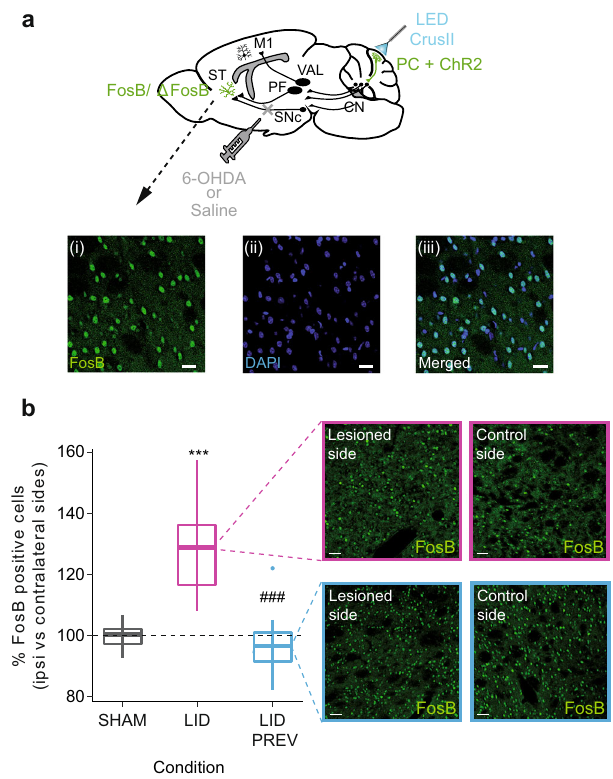
Fig. 7 Striatal overexpression of the dyskinetic marker FosB/ Δ FosB is restored by Purkinje cell stimulation. a Sagittal schematic showing neurons in the striatum expressing the dyskinetic marker FosB/ Δ FosB (green). The cerebello-thalamo-cortical and cerebello-thalamo-striatal pathways are represented in mice expressing ChR2-YFP in Purkinje cells (PC + ChR2, green) as well as the injection site 6-OHDA or saline (gray). ST: Striatum; SNc: substantia nigra pars compacta ; M1: Primary motor cortex, VAL: Ventroanterior-ventrolateral complex of the thalamus, PF: Parafascicular nucleus of the thalamus, CN: cerebellar nuclei, CrusII: Crus2 of the ansiform lobule. Insets: Postmortem histology showing FosB- expressing neurons (i), DAPI (ii), and merged (iii). Scale bars: 20 µ m. b Boxplots showing the ratio of cells expressing FosB between the striatum ipsilateral to the lesion and the striatum contralateral to the lesion in percentage (%) in the 4 different conditions (LID, magenta, N = 10; SHAM, gray, N = 10; and LID_PREV, blue, N = 10). Horizontal bars in boxplots represent the median. Magenta inset: Postmortem histology showing FosB- expressing neurons in dyskinetic animals in the striatum ipsilateral to the lesion ( left box ) and in the striatum contralateral to the lesion ( right box ). Scale bars: 20 µ m. Blue inset: Postmortem histology showing FosB- expressing neurons in preventive animals in the striatum ipsilateral to the lesion ( left box ) and in the striatum contralateral to the lesion ( right box ). Scale bars: 20 µ m. Boxplots represents the lower and the upper quartiles as well as the median. Vertical lines represent the median± std. Isolated points represent outliers of the distribution. Two-sided student t test. *** p < 0.001; ** p < 0.01; * p < 0.05. *Compared to SHAM; # compared to LID. Source data are provided as a Source Data fi le. See also Table